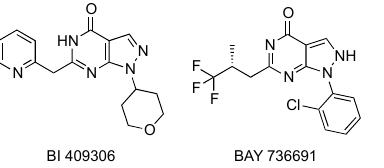
Figure 4. Chemical structures of the PDE9 inhibitors BI 409306 and BAY 736691.